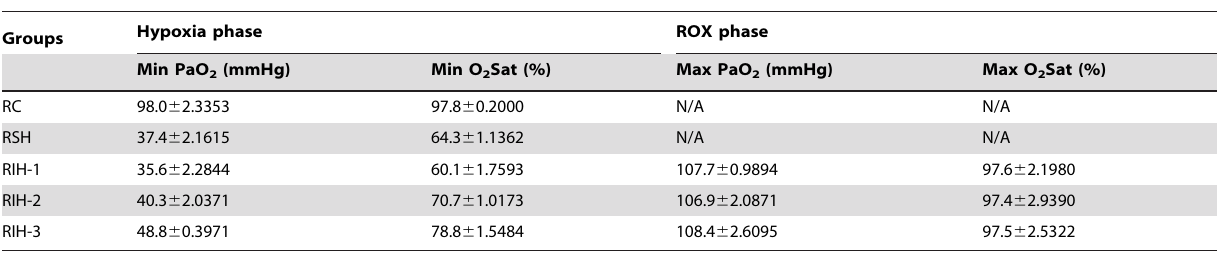
Table 2. Descriptive ABG results from preliminary tests.